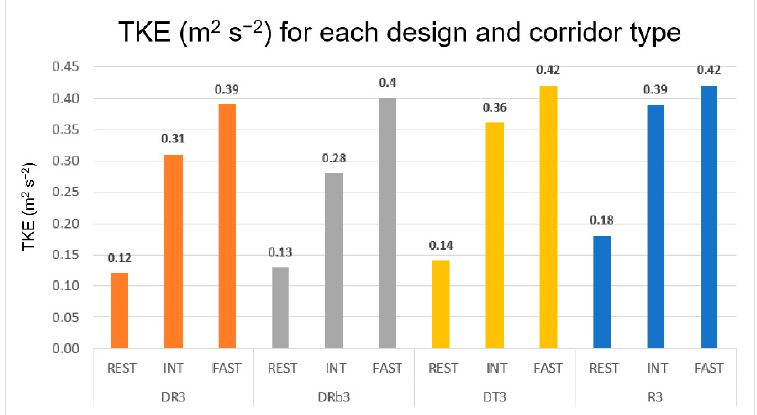
Figure 12. Median values of turbulent kinetic energy by corridor type: fast (FAST), resting (REST) and intermediate (INT) and design layout: rectangular boulder (R3), double rectangular boulder (DR3), double rectangular boulder with a small barrier (DRb3) and double trapezoidal boulder (DT3).